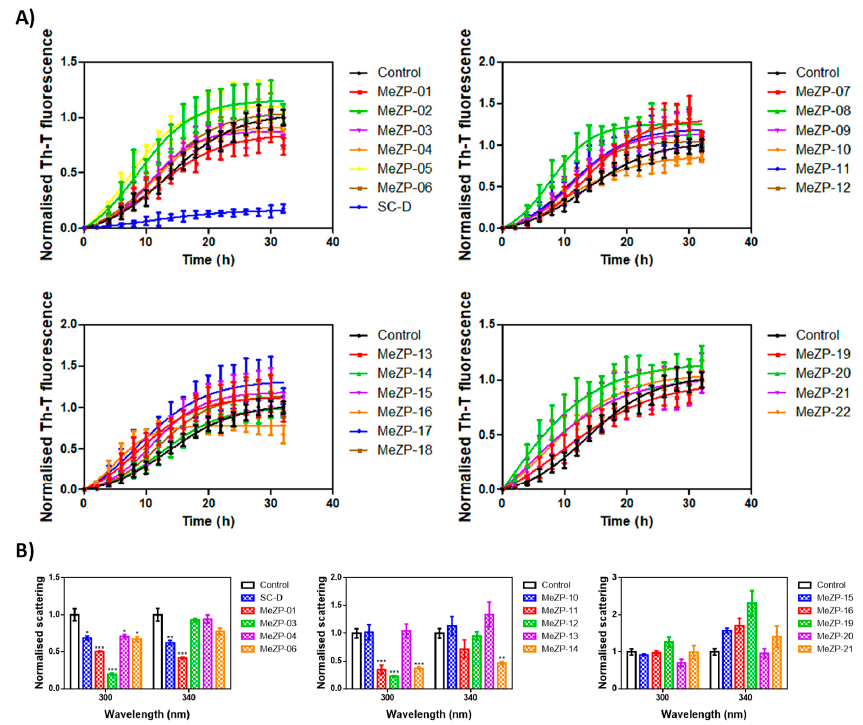
Figure 5. In vitro inhibitory characterization of compounds MeZP-01 to MeZP-22. ( A ) Aggregation kinetics of α -Syn in the absence (black) or presence of 100 µM concentrations of the different com- pounds (colored). SC-D was used as a reference (blue, left panel). Th-T fluorescence is plotted as a function of time. ( B ) Light scattering measurements at 300 and 340 nm of end-point aggregates in the absence (black) or presence of 100 µM concentrations of the different compounds (colored). SC-D was used as a reference (blue, left panel). The statistical significance was determined by a one-way ANOVA test with Dunnett’s multiple comparison (* p < 0.05; ** p < 0.01; *** p < 0.001). Th-T fluorescence and light scattering are plotted as normalized means; error bars represent SEs of mean values for N ≥ 3 in each experiment.